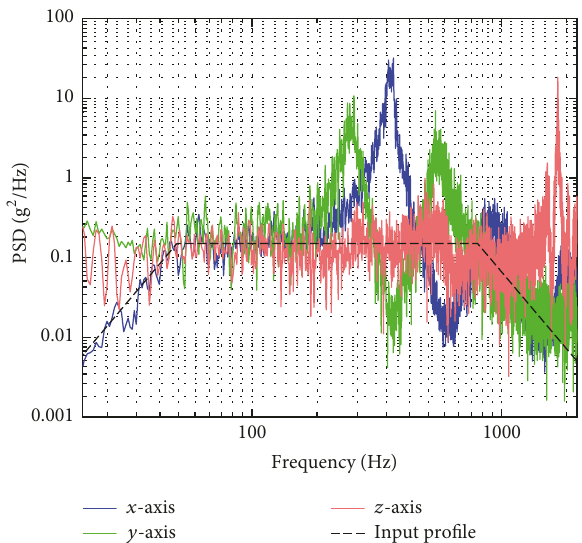
Figure 12: Example of the pyroshock simulating impulse shock test result.